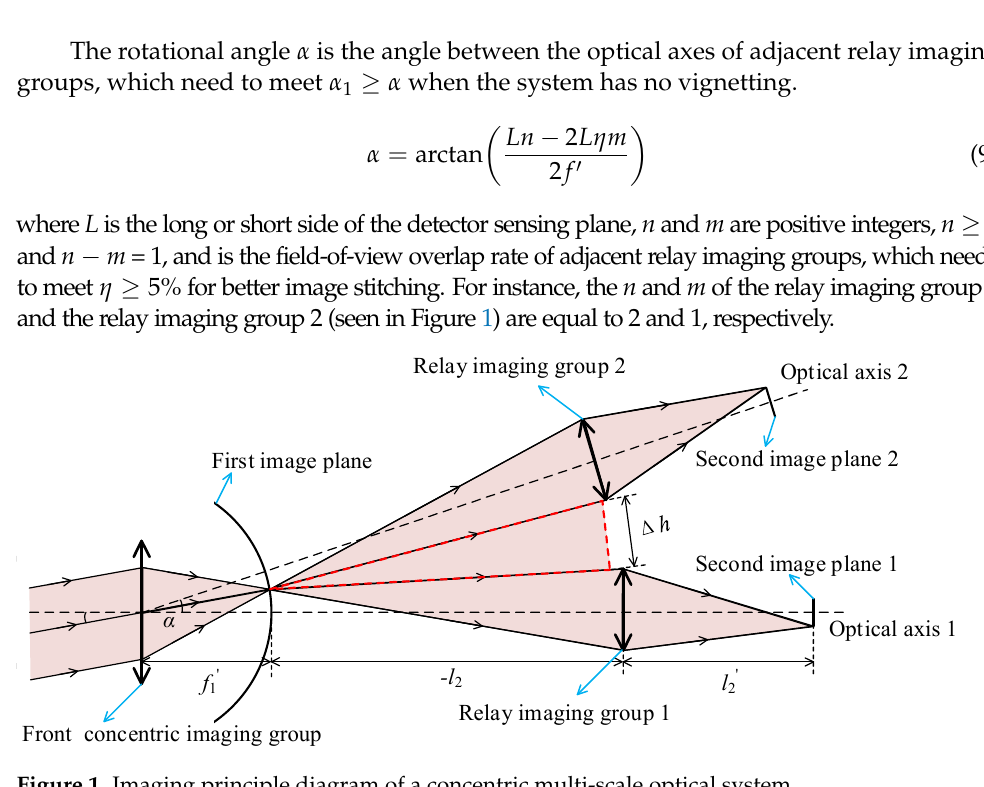
Figure 1. Imaging principle diagram of a concentric multi-scale optical system.